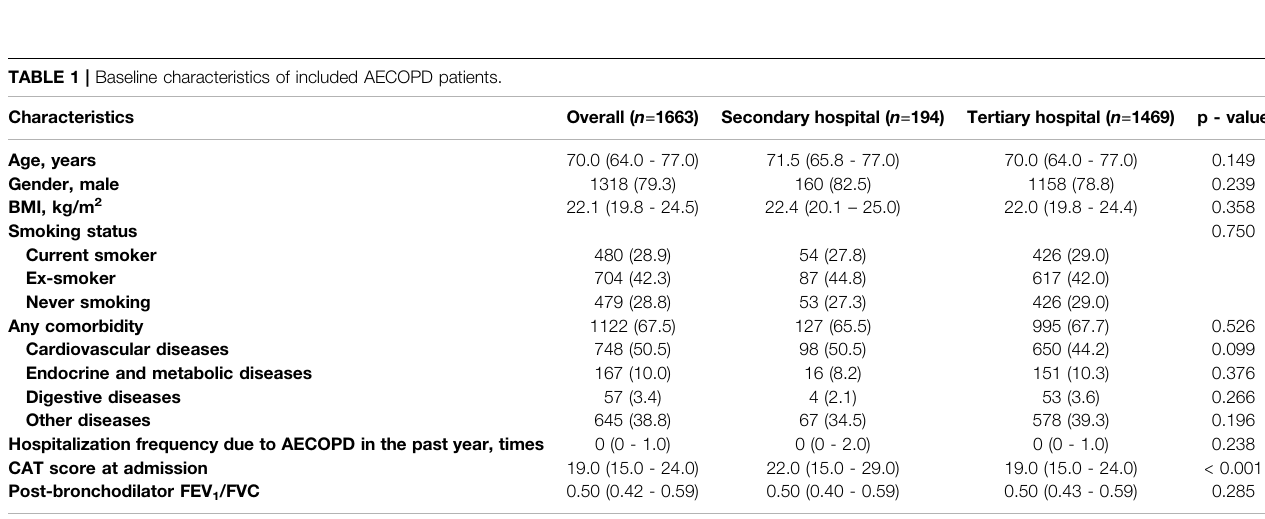
FIGURE 1 | Flowchart diagram of eligible study population.